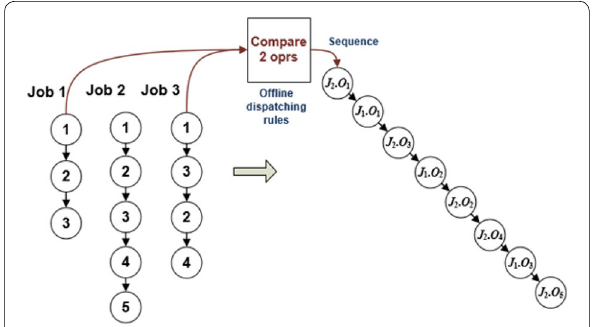
Figure 4 Using offline dispatching rules to build the sequence